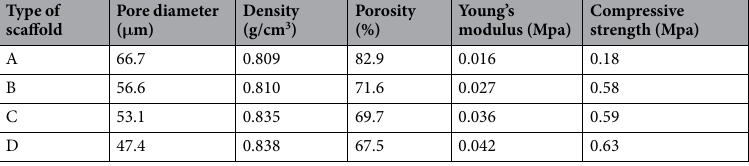
Table 3. Pore diameter, Density, percentage porosity and mechanical properties of the composites produced with various nHA